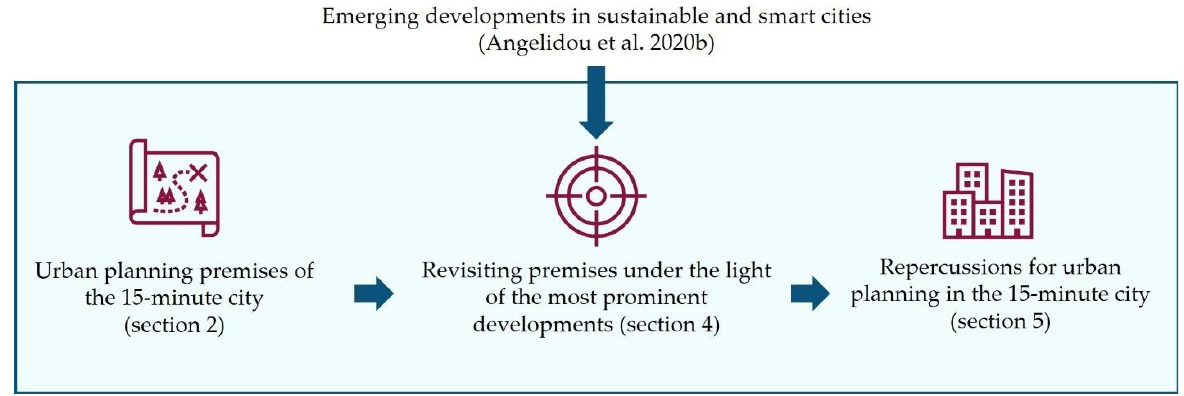
Figure 2. Research design (authors).